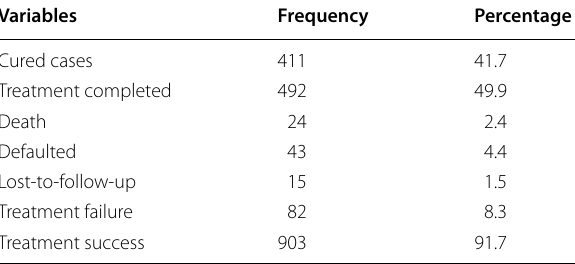
Table 2 Treatment outcomes of TB patients attending the